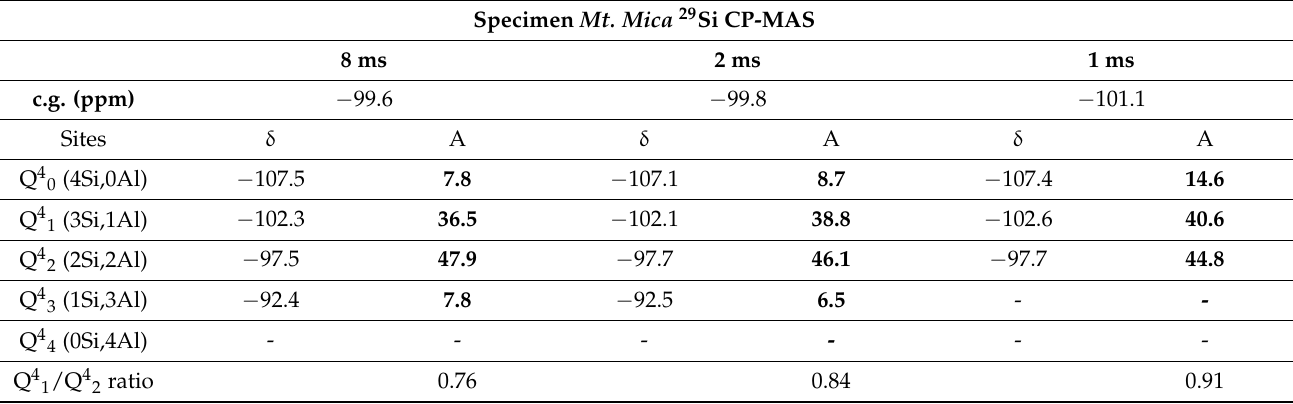
Table 5. Deconvolution of the 29 Si CP-MAS spectra of specimens Mt. Mica .